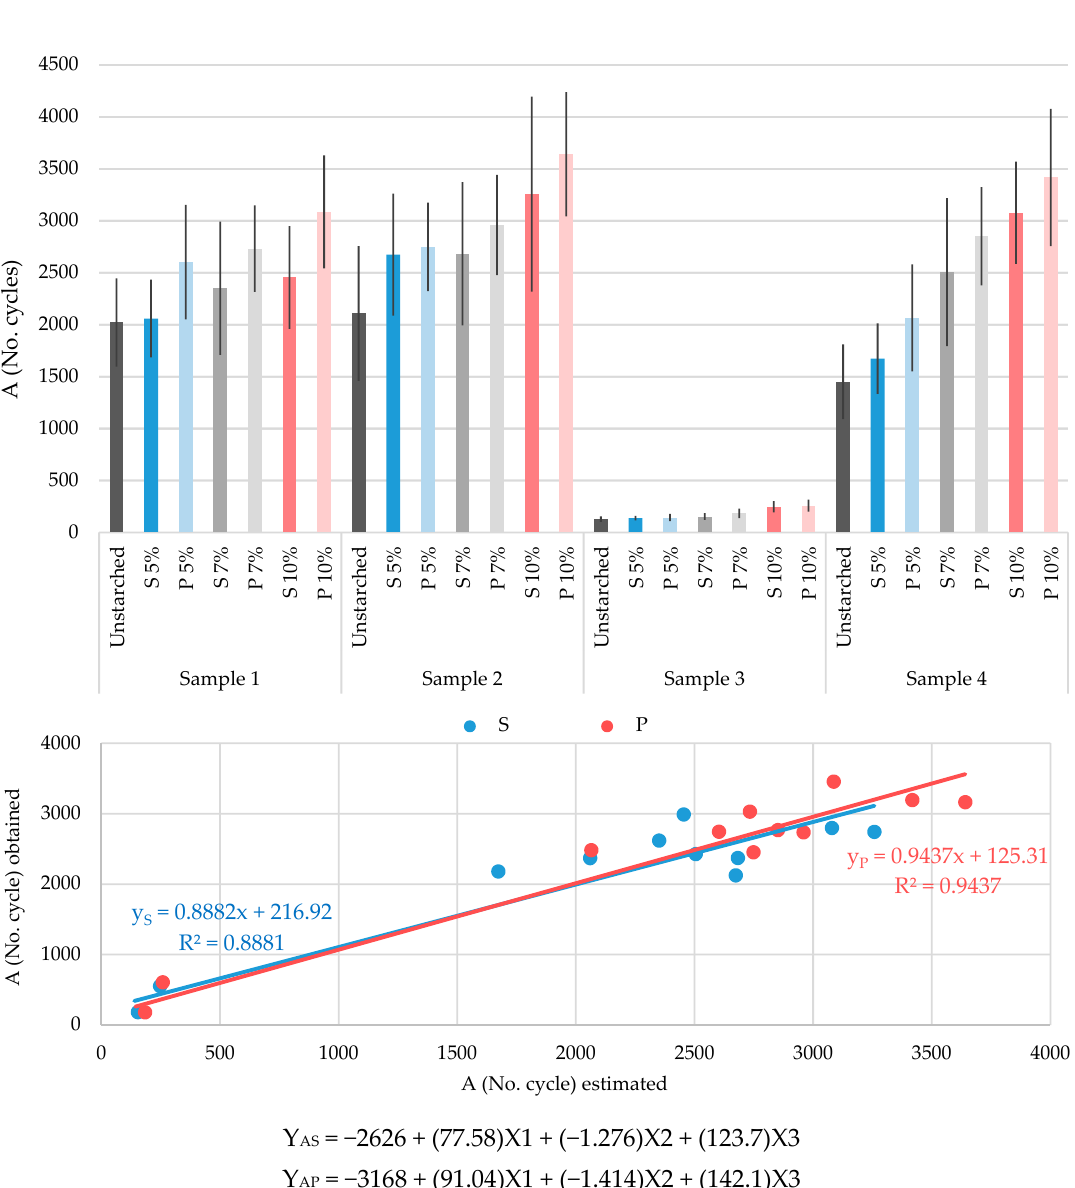
Figure 5. Diagram of abrasion resistance (A) of the tested yarns: unstarched yarns and yarns starched by standard and prewetting processes, with 5%, 7% and 10% starch mass